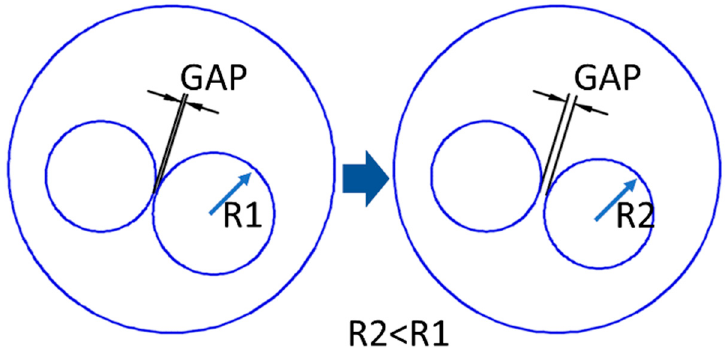
Figure 7. Gap between adjacent pores, before and after correction of the wall thickness.